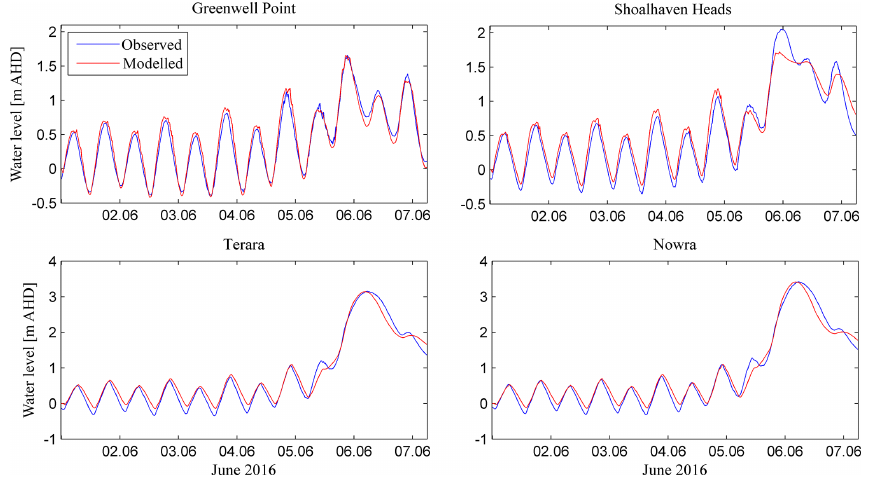
Figure 6. Observed and modelled water levels of the June 2016 storm event for monitoring points in the Shoalhaven River. Modelled water levels result from a model forcing by storm-tide and river discharge using two-open boundaries.